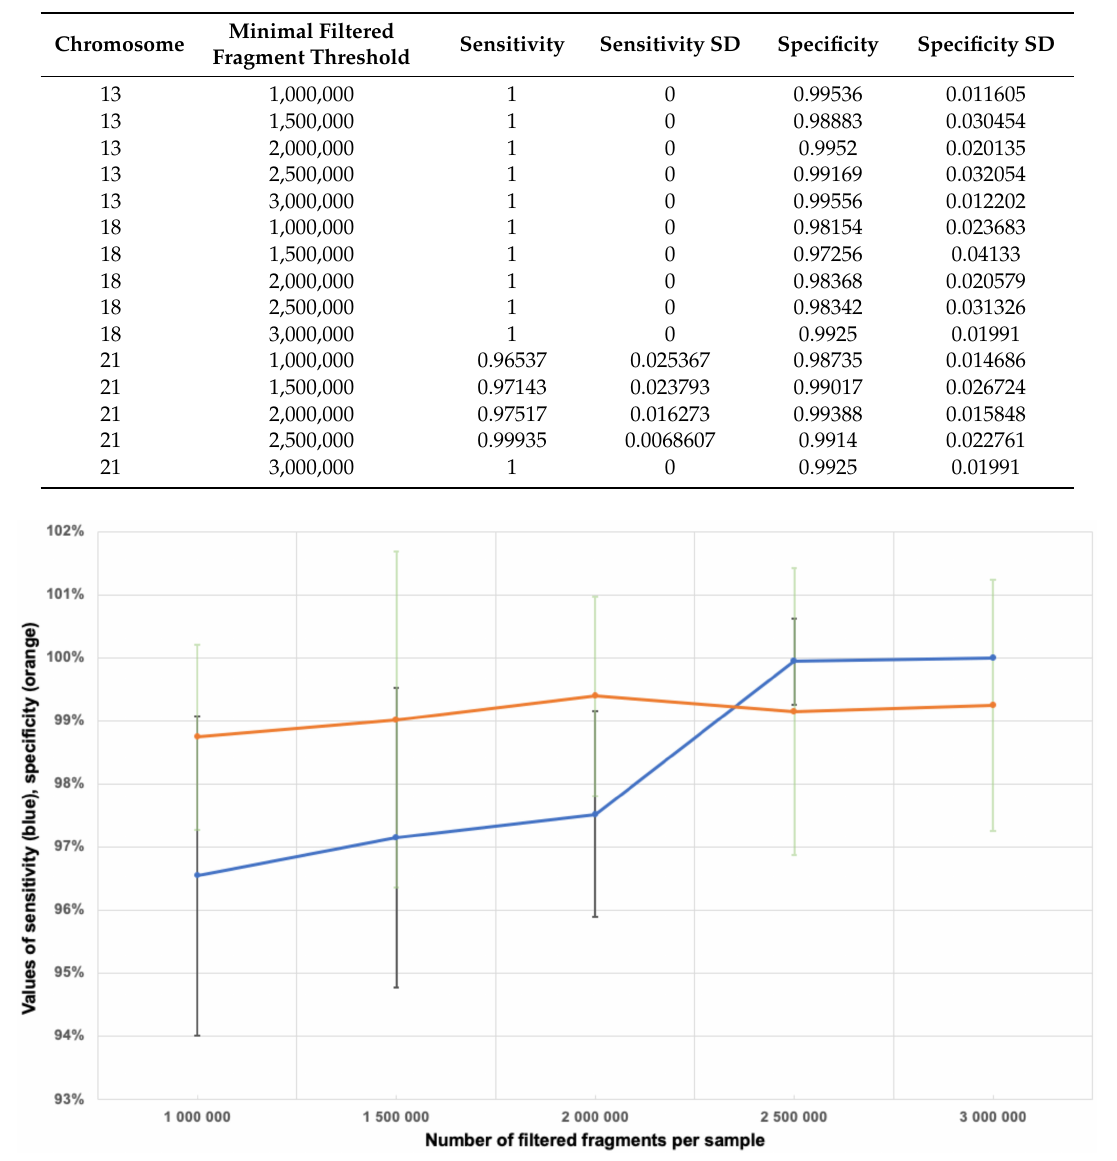
Figure 5. The sensitivity (blue line) and specificity (orange line) values of the determination of aneuploidy on Chromosome 21 with regard to the standard deviation, depending on the number of filtered fragments per